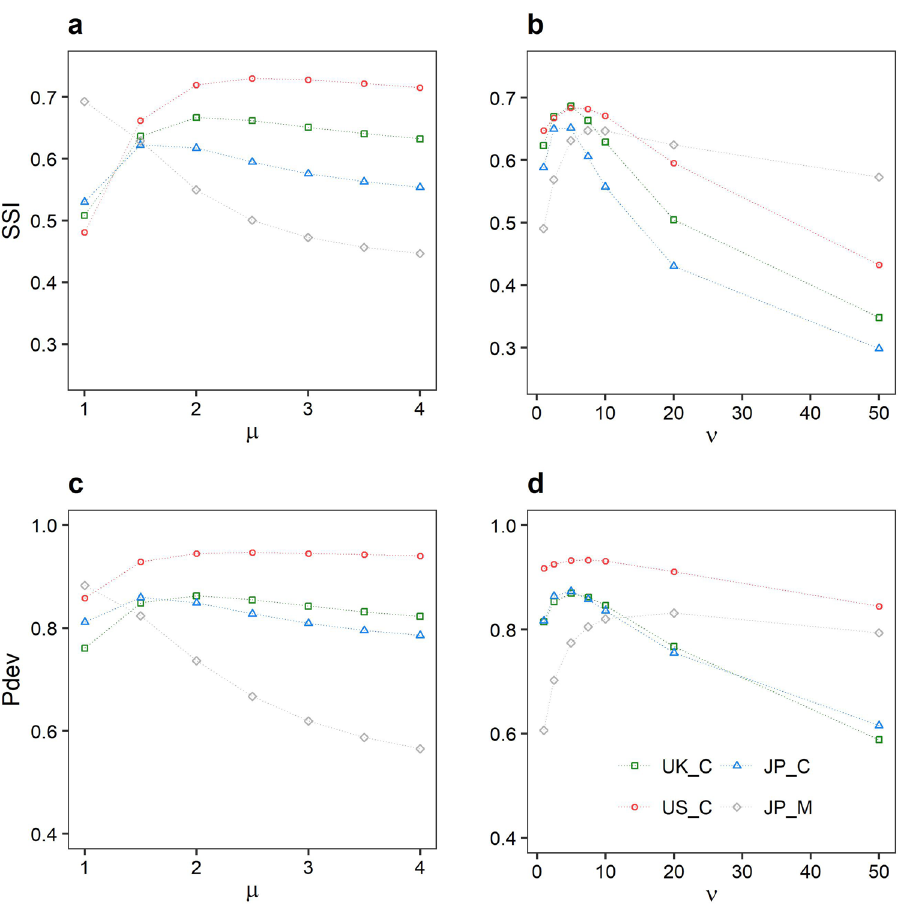
Figure 5. Relationship between proposed kernel-based radiation model’s parameters and goodness-of-fit indicators for UK_C, US_C, JP_C, and JP_M datasets. ( a , b ) Variation of SSI (Sørensen similarity index) for µ and ν . ( c , d ) Variation of Pdev (Percent deviance explained) for µ and ν . Note that the best parameters were ν = 5.0, µ = 2.5, ν = 5.0, and µ = 1.0, for UK_C, US_C, JP_C, and JP_M datasets, respectively, based on SSI, as with Pdev.